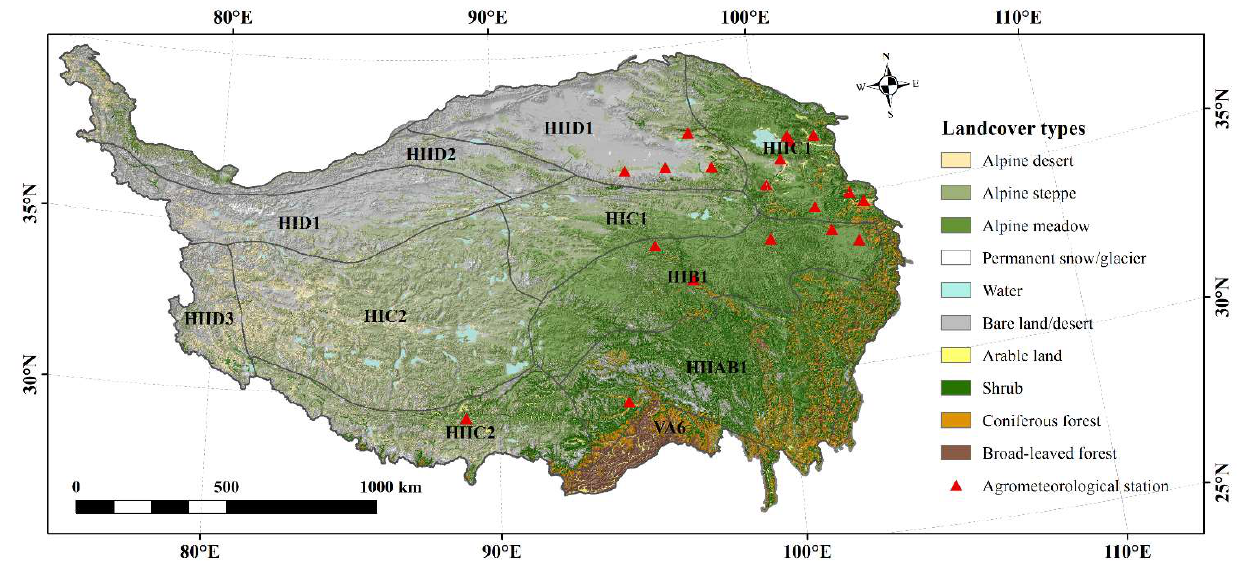
Figure 1. Spatial distributions of the land cover types and eco-geographical regions of the study area.